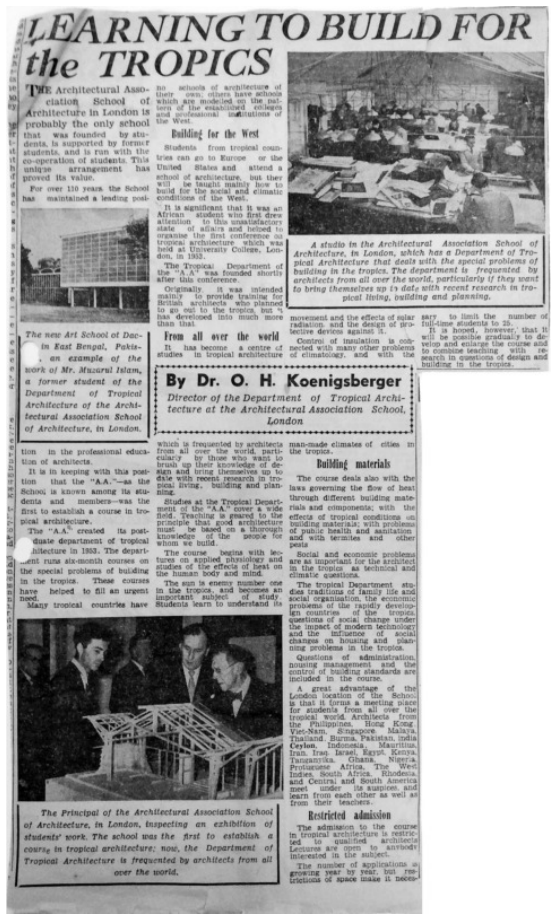
Figure 3. Press cutting emphasizing the